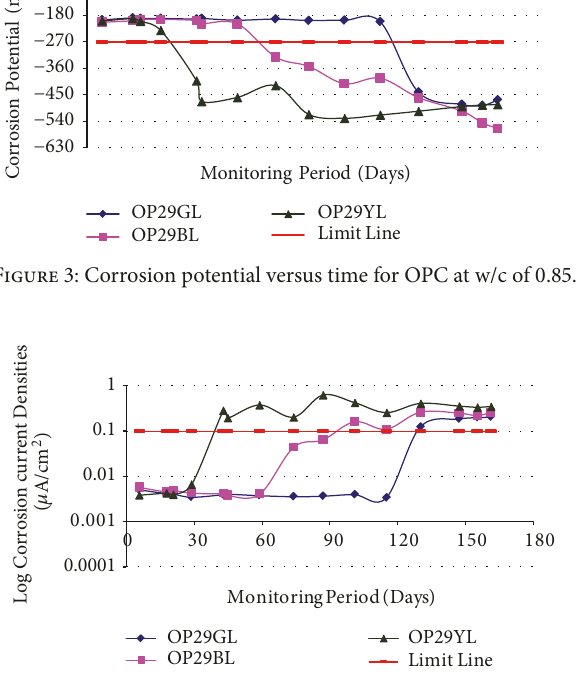
Figure 4: Log corrosion current densities versus time for OPC at w/c